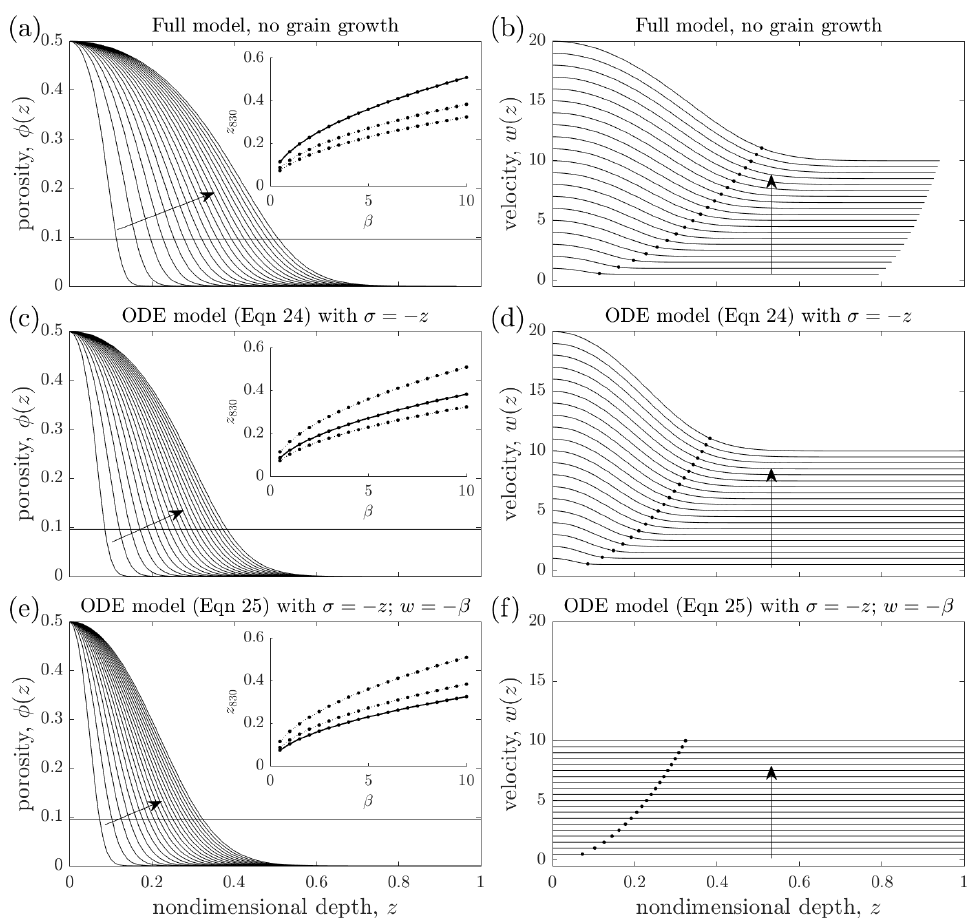
Figure 3. Accumulation dependence in the absence of grain-size evolution in three different models. The left panels show porosity φ as a function of depth z . The horizontal line shows the porosity corresponding to z 830 (0.096). The right panels show velocity w as a function of z . The dots show the depth at which the firn reaches 830kgm − 3 . Each row shows the results of 20 simulations each using a different accumulation rate β , which varies linearly between 0.5 and 10. The arrows show the direction of increasing β . All simulations = 0.01m 2 , and n = m = 1. They also all prescribe r 2 equal to its surface value r 2 = 0.029 used b 0 = 0.1ma − 1 , φ s = 0.5, T s = 253.15K, r 2 s f (cid:113) = 0.5mm). Scales and other parameters are the intermediate values everywhere (corresponding to a dimensional grain radius of 0 . 029 r 2 0 from Table 3). (a, b) Steady-state solutions of the full model (Sect. 2.4). (c, d) Solutions to Eq. (24), which assumes r 2 (z) = r 2 s , σ(z) = − z . (e, f) Solutions to Eq. (25), which assumes r 2 (z) = r 2 s , σ(z) = − z , and w(z) = − β . The insets in (a) , (c) , and (e) show the dependence of firn thickness z 830 on β for all three sets of simulations (dotted curves). The three dotted curves are the same in each inset, and the solid curve in each inset corresponds to the results shown in the respective